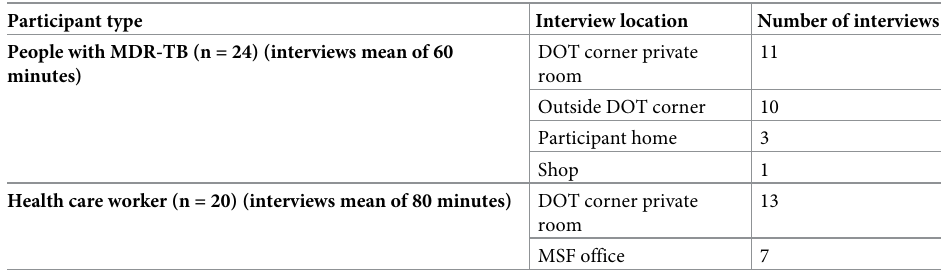
Table 3. Interview